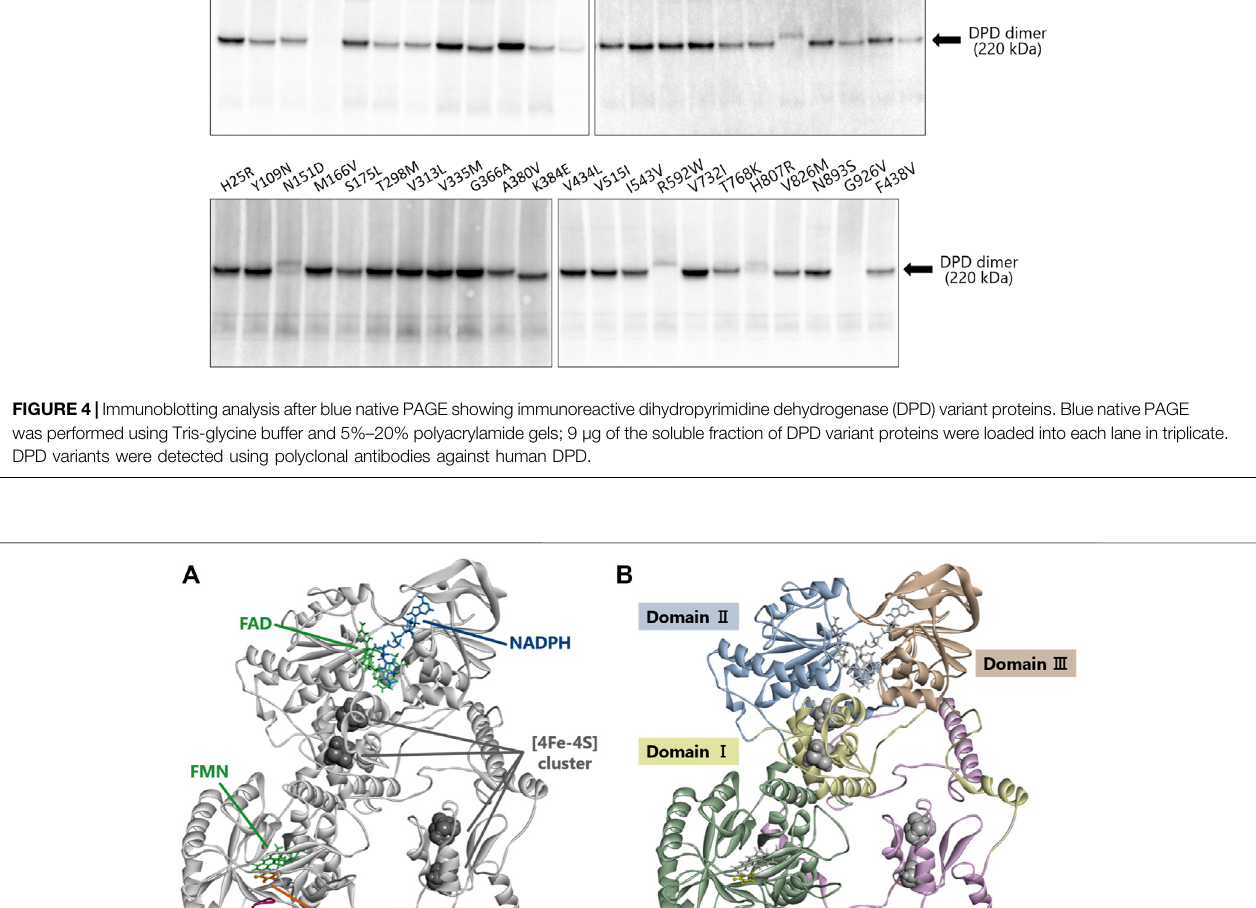
Frontiers in Pharmacology |